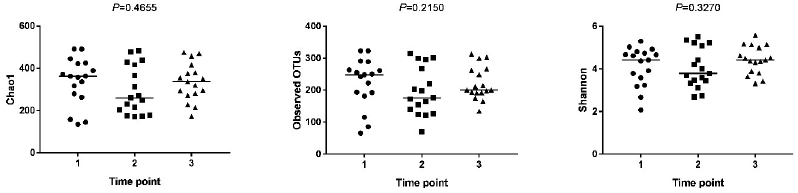
Fig 1. Juvenile green turtle fecal bacterial alpha diversity across time points in rehabilitation. Alpha diversity indices (Chao1, Observed OTUs, and Shannon Diversity Index) showed no significant differences in juvenile green turtle ( Chelonia mydas ) fecal bacterial diversity across time points in rehabilitation (1 = admission, 2 = mid- rehabilitation, 3 =